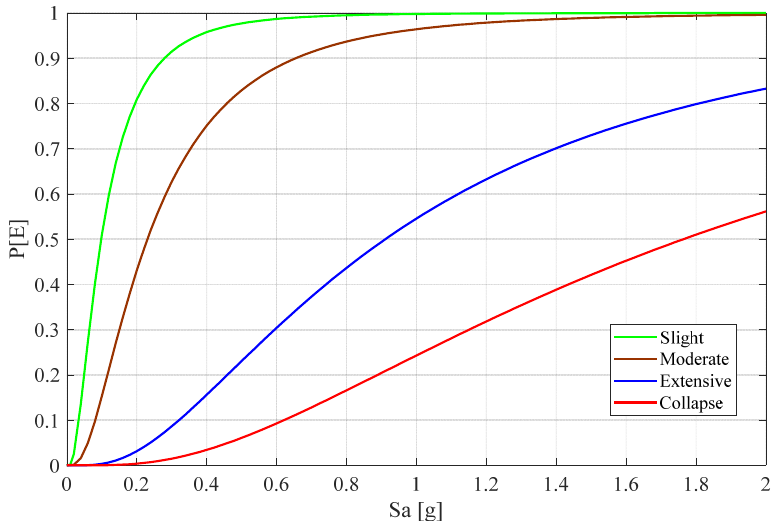
Figure 11. Fragility functions for low-rise RC building for bare frame model considering soil–structure interaction.